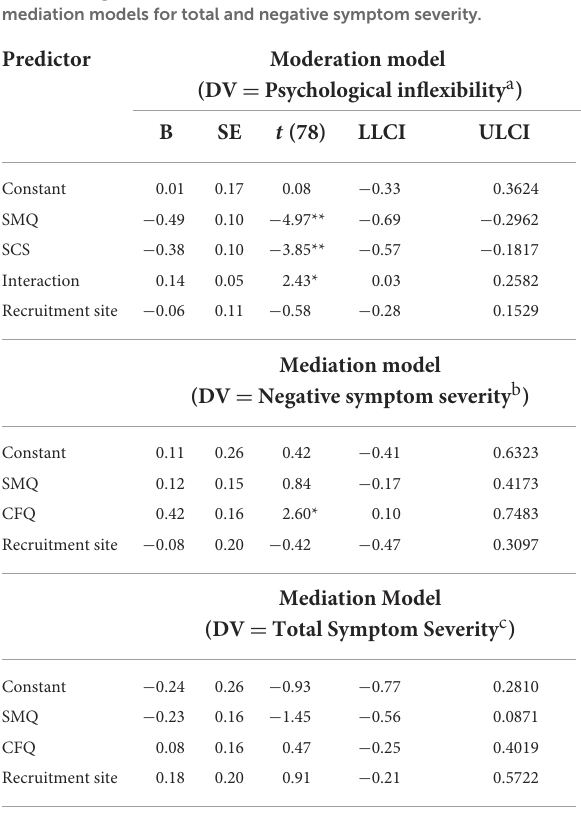
TABLE 6 Regression models with direct effects in the moderated mediation models for total and negative symptom severity.